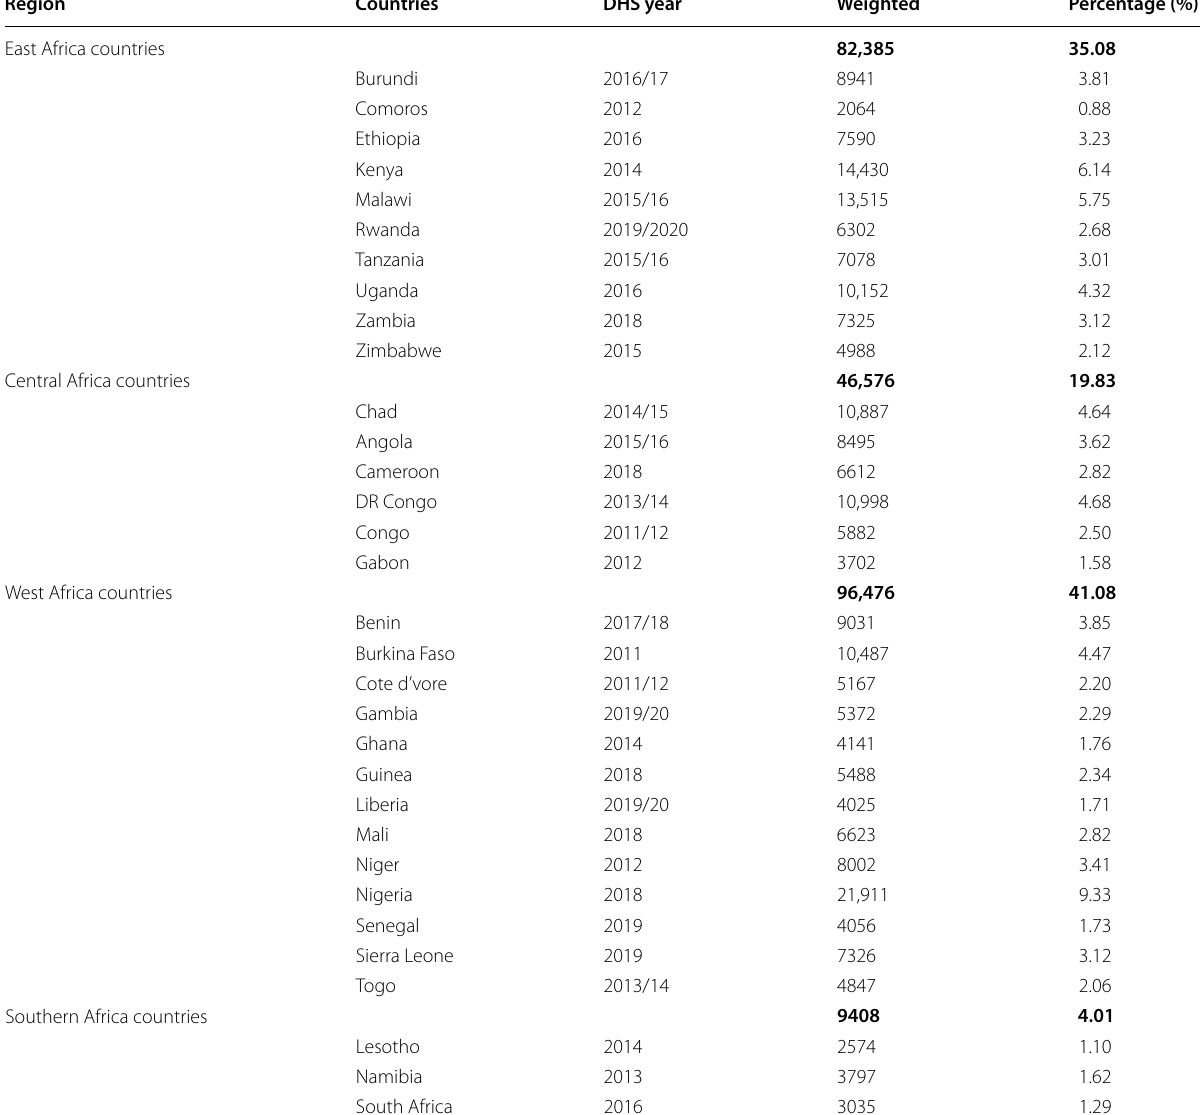
Table 1 Sample size determination in the study of magnitude ORS packets or ORS pre-packaged liquids among women